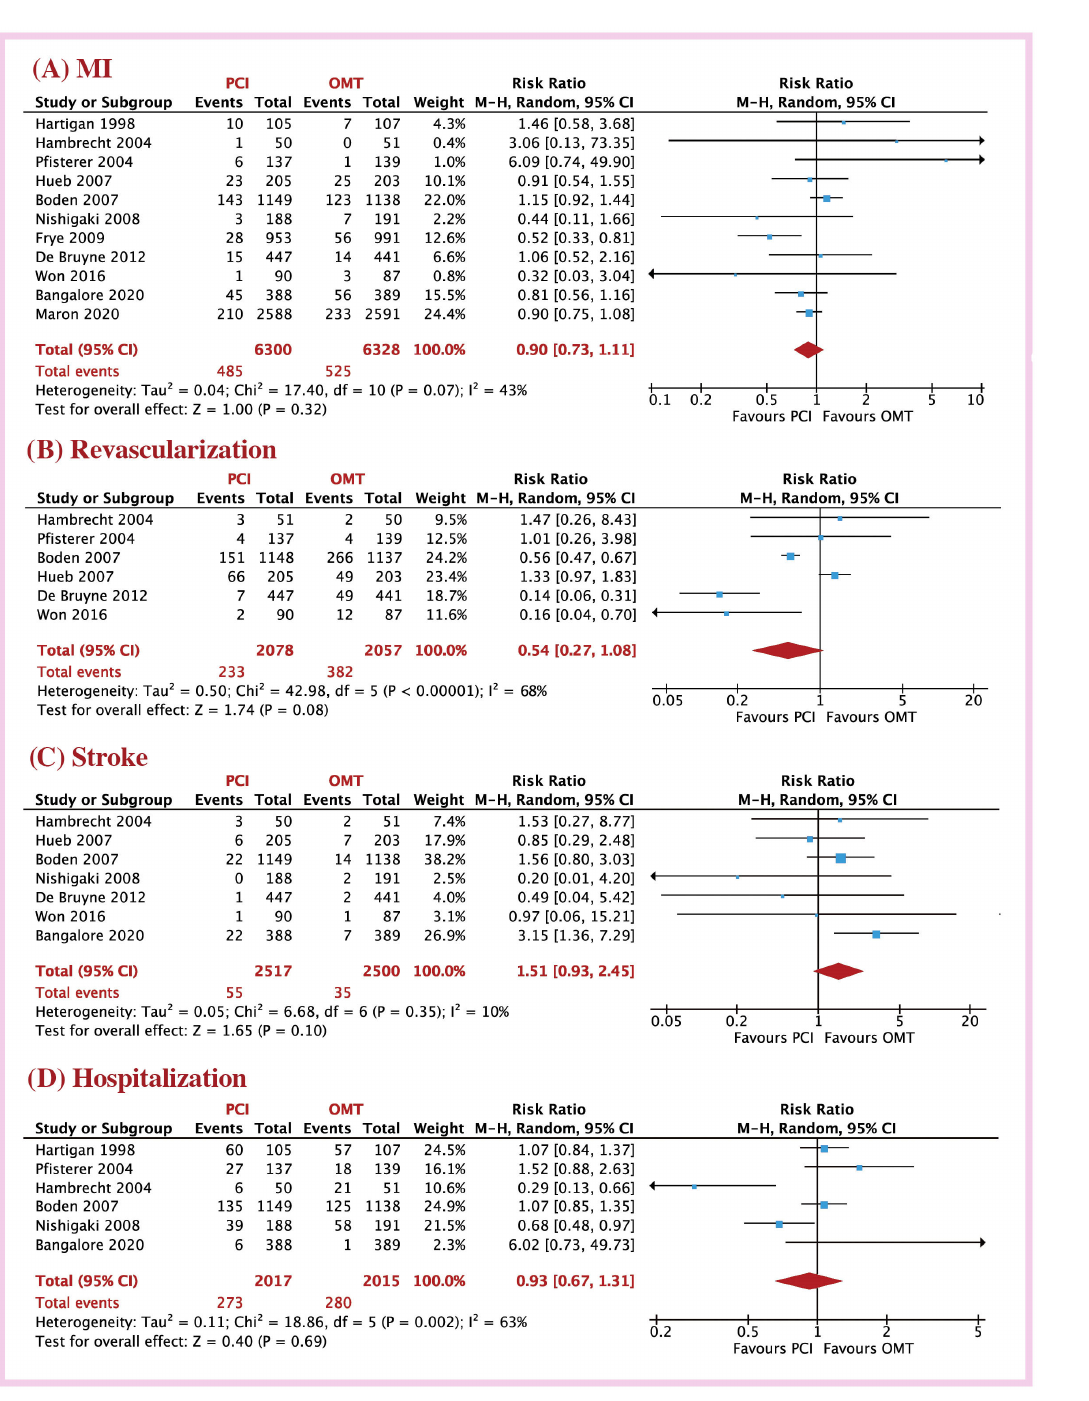
Figure 2. Risk ratio of outcome with PCI versus OMT in CCS patients; ( A ) MI, ( B ) revascularization, ( C ) hospitalization, ( D ) stroke. Abbreviations: CCS: chronic coronary syndrome; PCI: percutaneous coronary intervention; OMT: optimal medical therapy; MI: myocardial infarction.